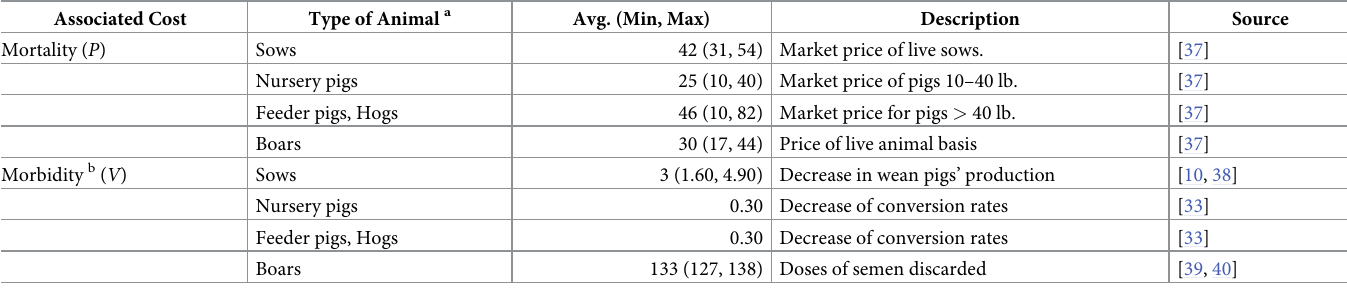
Table 3. Economic loss (USD) due to mortality or morbidity per type of